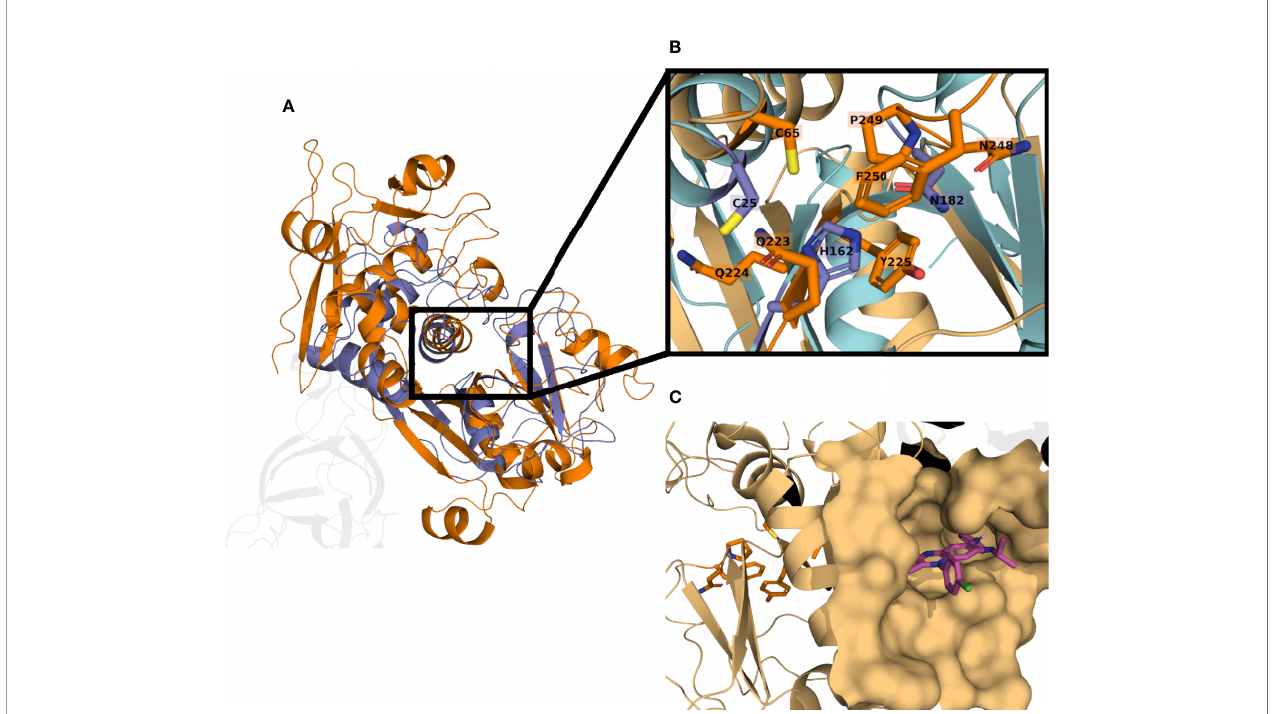
FIGURE 6 | T. cruzi calpain-like peptidase Q4CMV9 model aligned with cruzipain structure 4PI3. Structural similarities can be appreciated between cruzipain (blue) and the calpain-like peptidase Q4CMV9 (orange) (A) ; unaligned residues in the C-terminal domain are shown transparent. The calpain-like peptidase shows an inactive catalytic site, lacking the basic residue, typically a histidine, necessary to deprotonate the cysteine (B) . The binding site of clofazimine (magenta) is located far from the inactivated catalytic site (orange residues), suggesting another mechanism of action (C) .